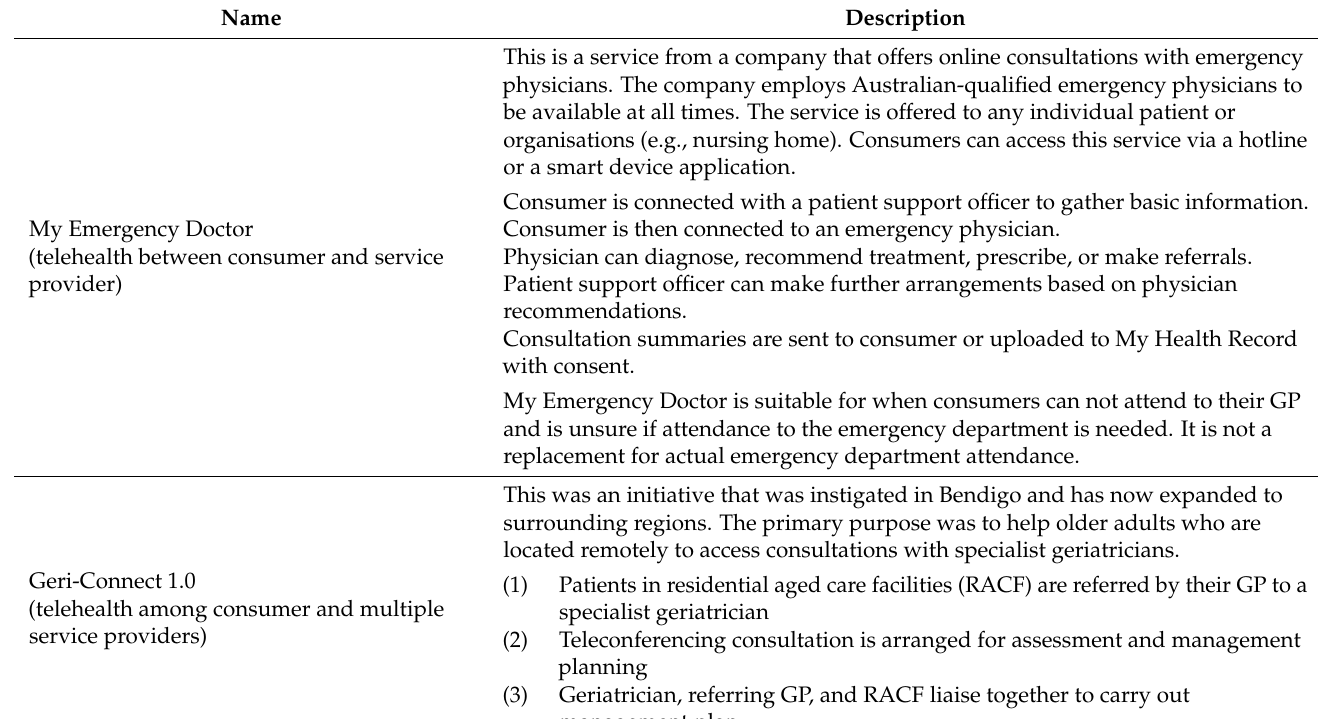
Table A4. Summary document of novel virtual care initiatives provided to stakeholders to summarise survey results and facilitate co-production